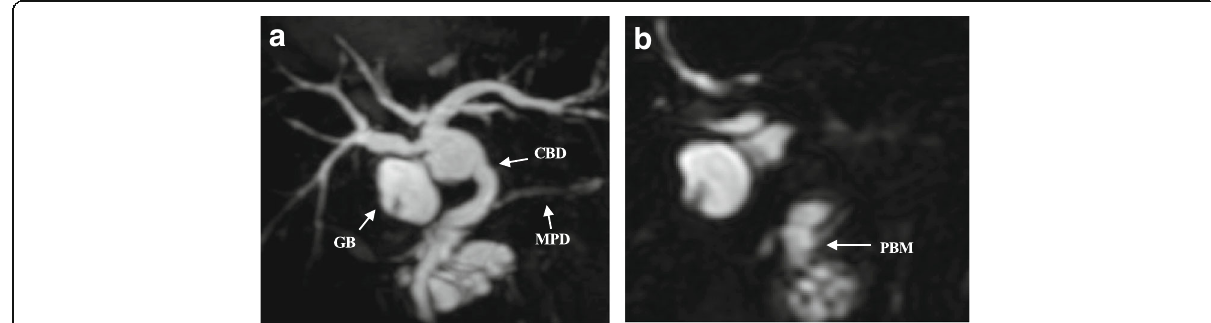
Fig. 2 a , b Magnetic resonance imaging (MRI) showed a pancreaticobiliary maljunction with cystic dilatation of the common bile duct (type Ia